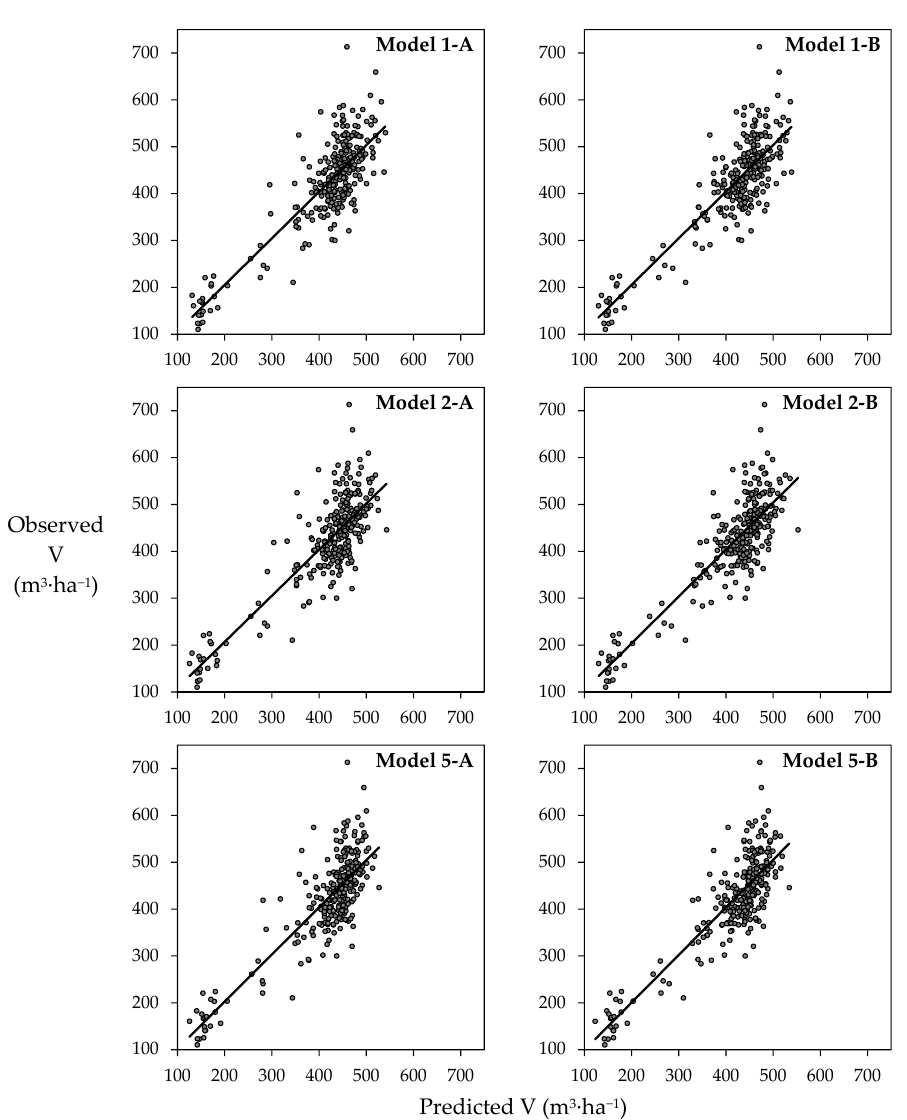
Figure 3. Observed vs. predicted stand volume (V) for six selected stand-level volume models (validation dataset) described in Table 5. The solid line represents fitted linear model.